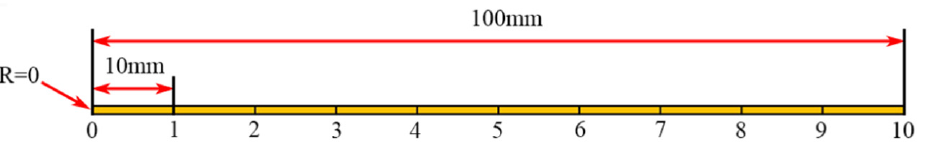
Figure 3. Schematic diagram of Au bump height measurement method.